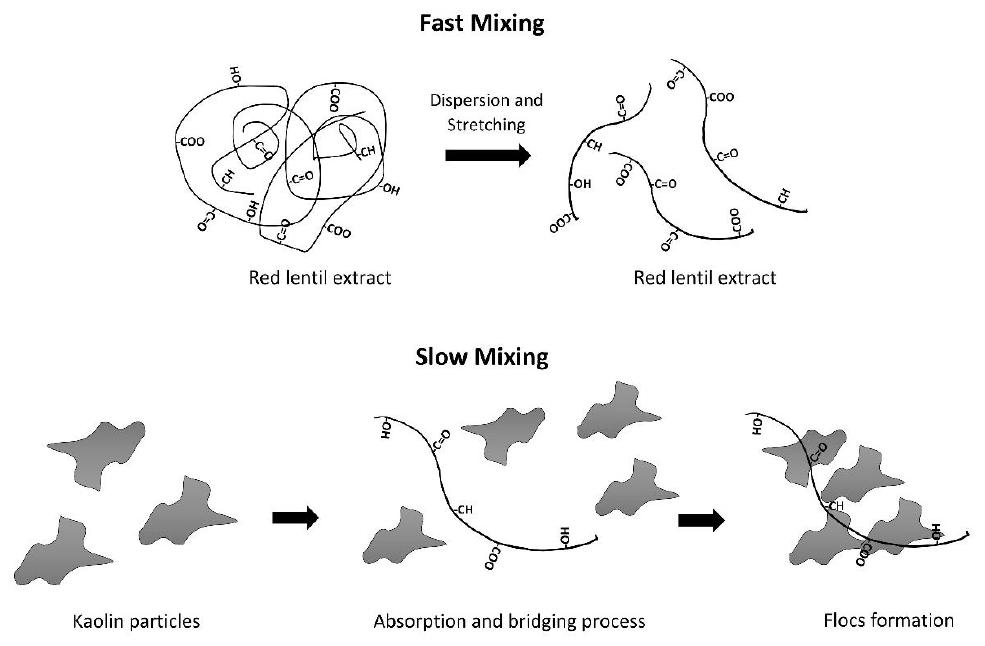
Figure 8. Proposed mechanism for red lentil extract as coagulant.